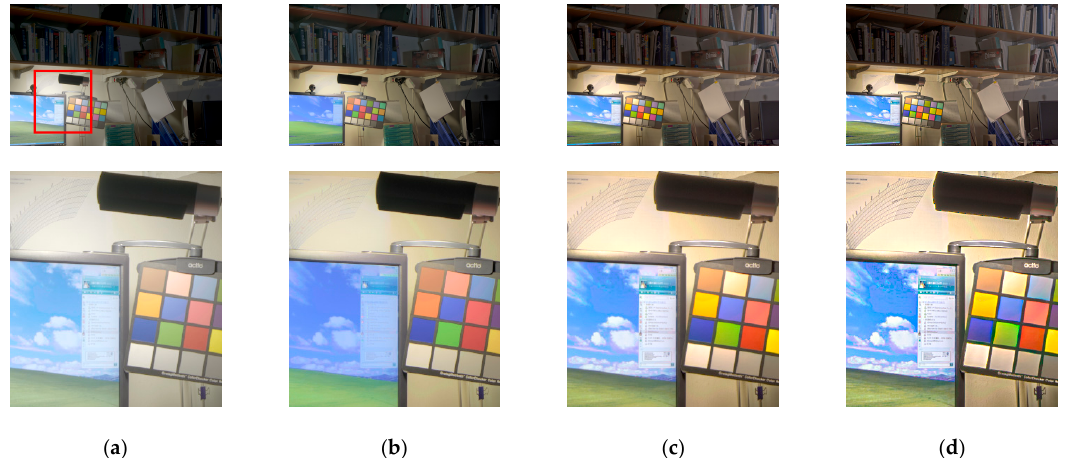
Figure 8. Thumbnails of test images.